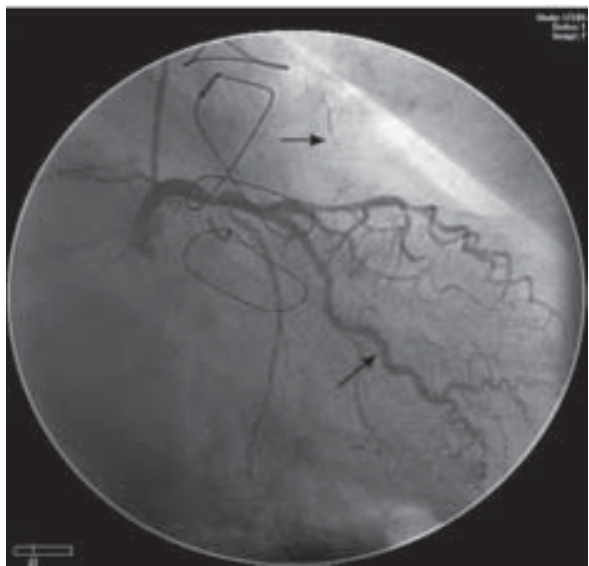
Fig. 4b - late restudy - 62 months after myocardial revascularization (Mg Artery without obstructive lesion)